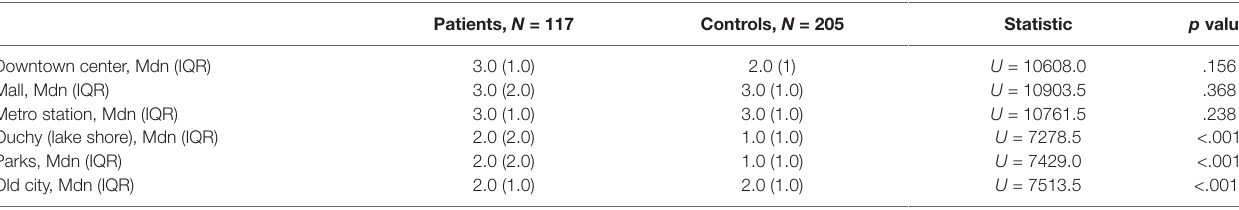
TABLE 3 | Negative perception of various urban spaces.